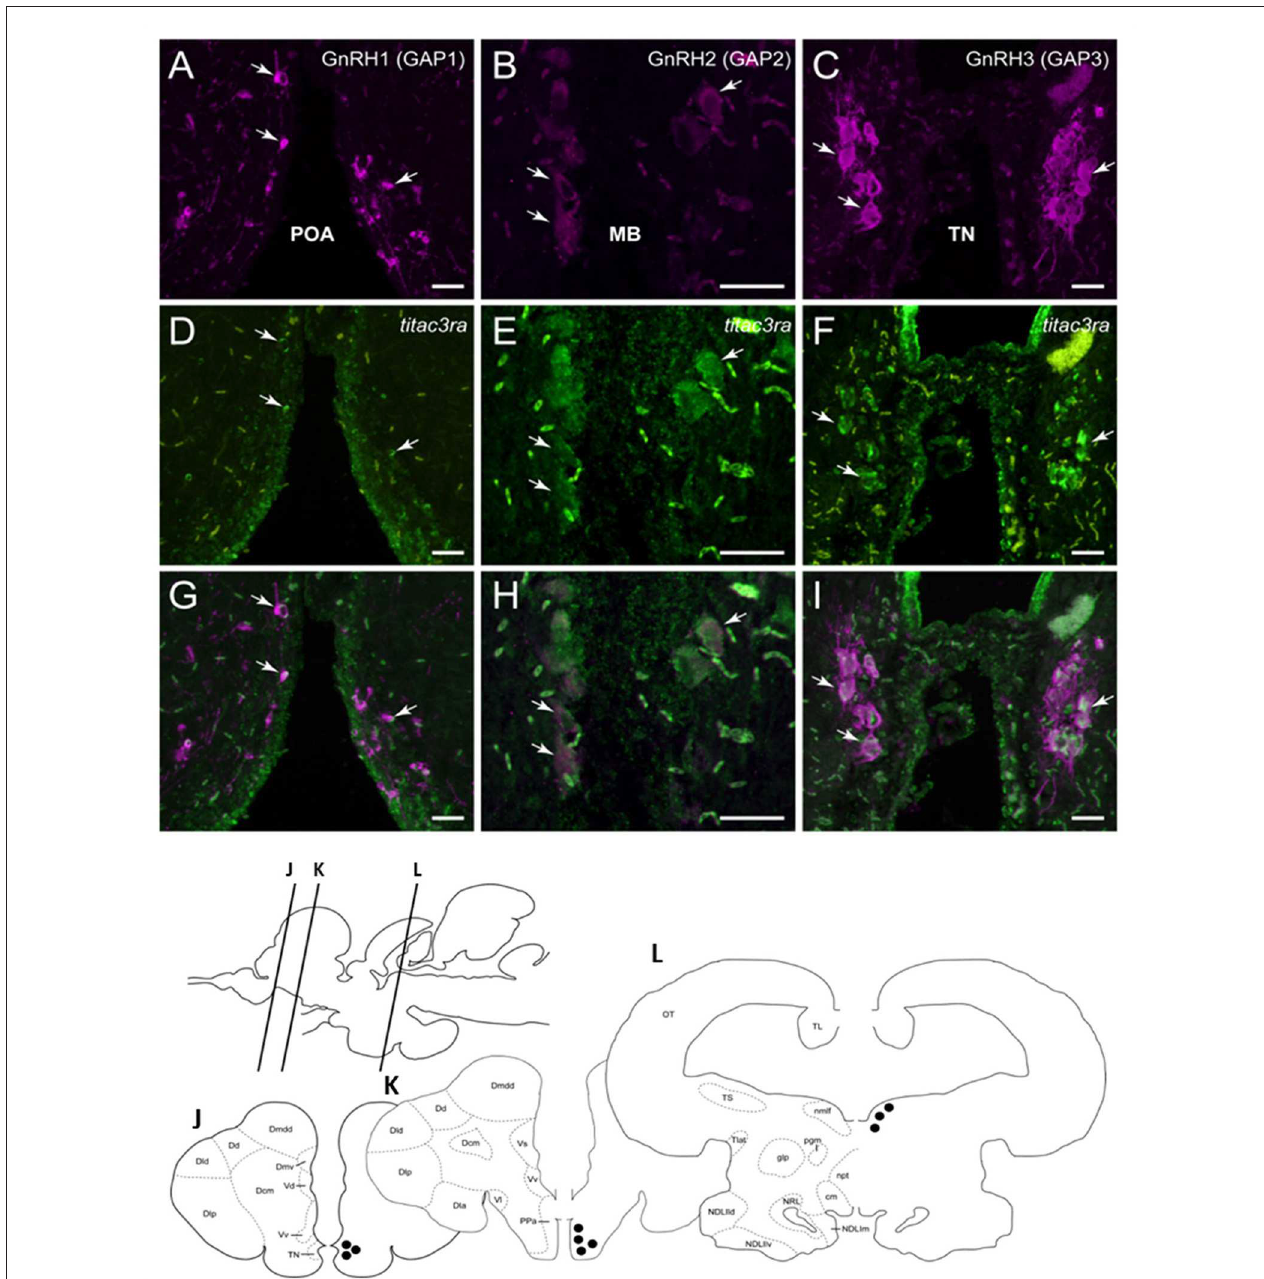
FIGURE 7 | Tilapia tac 3ra is expressed in GnRH1 and GnRH3, but not in GnRH2, neurons in tilapia brain. Double-labeled ISH-IF of tac 3ra mRNA (green, D,E,F ) and GnRH1 (red, A,D,G ), GnRH2 (red, B,E,H ), and GnRH3 (red, C,F,I ) in the tilapia brain. Scale bar, 50 µ m. Schematic representation of localization of three GnRH-associated peptides (GAP1, GAP2, and GAP3)-immunoreactive (-ir) neurons in the brain of tilapia. Lines on a schematic sagittal drawing view of the tilapia brain indicate levels of transverse brain sections (J–L) shown below. Black dots indicate the location of GnRH1, GnRH2 and GnRH3 (GAP1, GAP2, and GAP3-ir) neurons. GAP3-ir cells in the terminal nerve ganglia at the caudal-most olfactory bulbs (TN, J ); GAP1-ir cells in the anterior part of the parvocellular preoptic nucleus (PPa, K ) and GAP2-ir cells in the midbrain nucleus of the medial longitudinal fasciculus (nmlf, L ). cm, mammillary body; Dcm, medial subdivision of central part of the dorsal telencephalon; Dd, dorsal part of the dorsal telencephalon; Dla, anterior subdivision of lateral part of the dorsal telencephalon; Dld, dorsal subdivision of lateral part of the dorsal telencephalon; Dlp, posterior subdivision of lateral part of the dorsal telencephalon; Dmdd, dorsal part of dorsal subdivision of medial part of the dorsal telencephalon; Dmv, ventral subdivision of medial part of the dorsal telencephalon; glp, posterior part of the glomerular nucleus; NDLlld, dorsal subdivision of lateral part of the diffuse nucleus of the inferior lobe; NDLllv, ventral subdivision of lateral part of the diffuse nucleus of the inferior lobe; NDLlm, medial part of the diffuse nucleus of the inferior lobe; npt, posterior tuberal nucleus; NRL, nucleus of the lateral recess; OT, optic tectum; pgm, medial preglomerular nucleus; TL, longitudinal torus; Tlat, nucleus of the lateral torus; TS, semicircular torus; Vd, dorsal part of the ventral telencephalon; Vl, lateral part of the ventral telencephalon; Vv, ventral part of the ventral